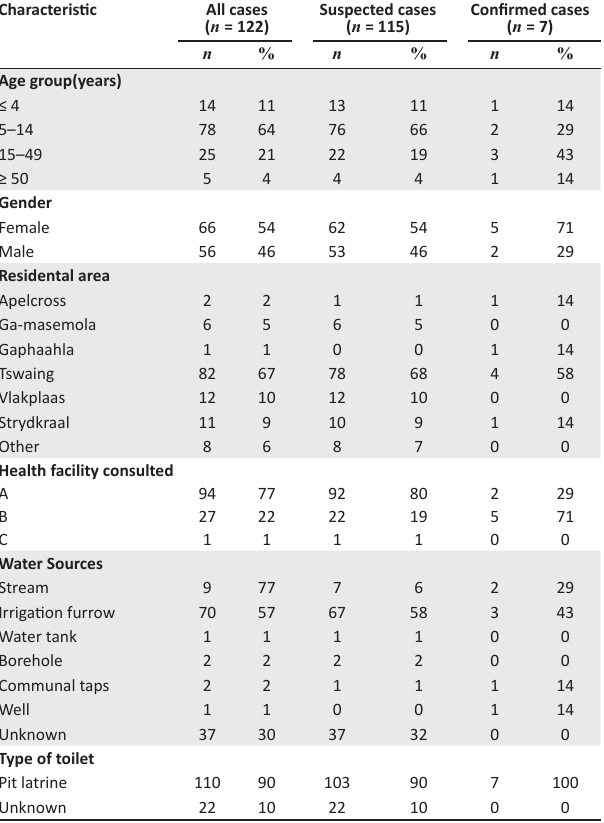
FIGURE 4: Snapshot from a maximum likelihood phylogenetic tree drawn using single nucleotide polymorphism alignments from whole-genome sequencing data of Salmonella Typhi isolates from South Africa. The blocked region highlights a cluster of related isolates sourced at the Sekhukhune District, Limpopo province, November to January 2018.